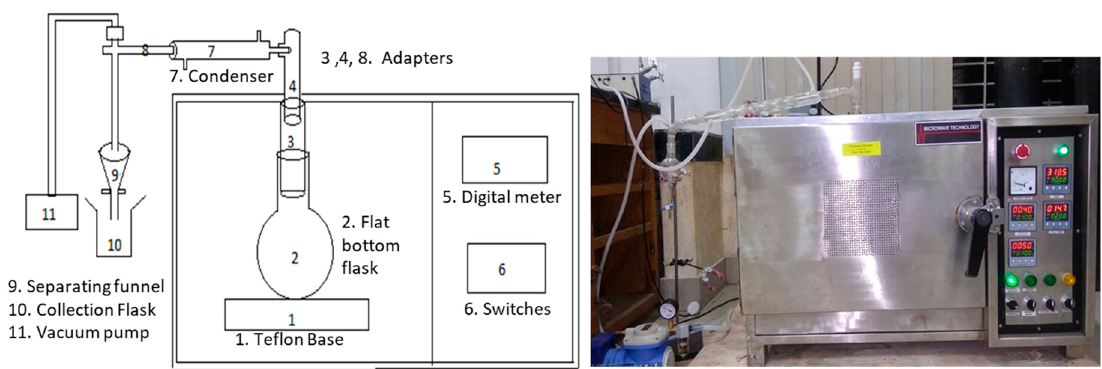
Figure 2. Schematic diagram and actual picture of microwave extraction set up.